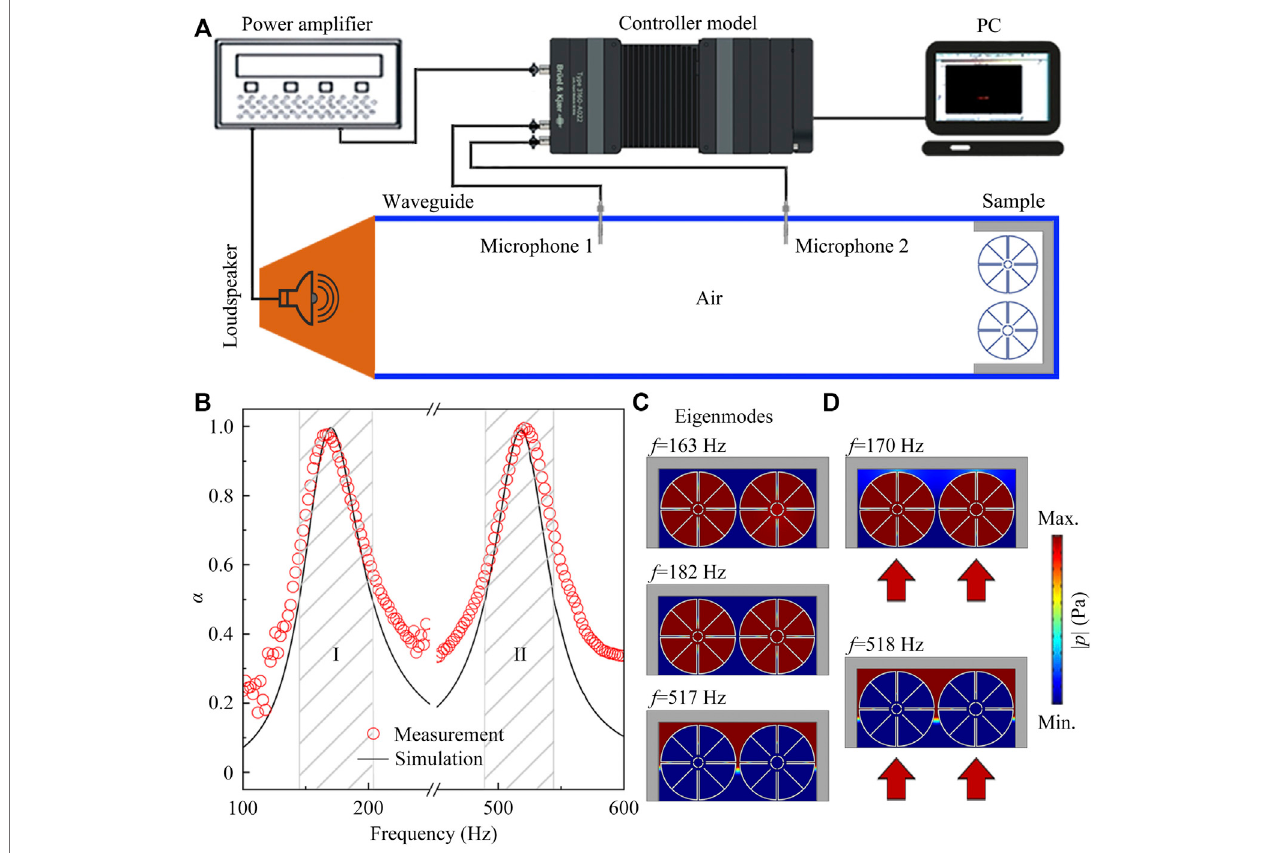
FIGURE 2 | (A) Experimental set-up. (B) Measured and simulated sound absorption spectra, and black shaded regions are two working bands of the unit cell (I: 145 – 203 Hz, II: 490 – 544 Hz). (C) Simulated pressure amplitude eigenfunctions of the unit cell at 163 Hz, 182 Hz, and 517 Hz. (D) Simulated distributions of pressure amplitude in the unit cell created by a normal incidence of sound (red solid arrows) at 170 and 518 Hz.